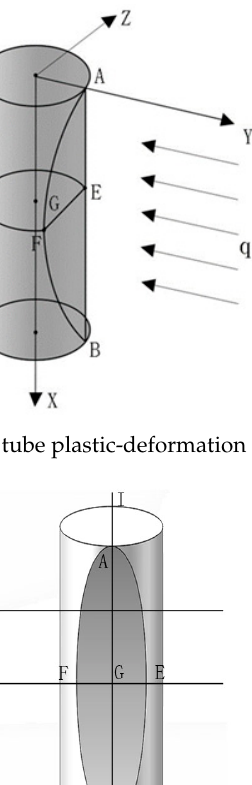
Figure 5. Section in the Ⅱ - Ⅱ direction. This study regarded wellbore deration as the coordinate axis and established a Cartesian coordinate system, assuming that the radius of the metal circular tube was R , and the plastic- deformation length of the casing collapse was 2 L . Through the geometric relation, the coordinates of each point at the deformation boundary could be expressed as shown in Figure 3. (